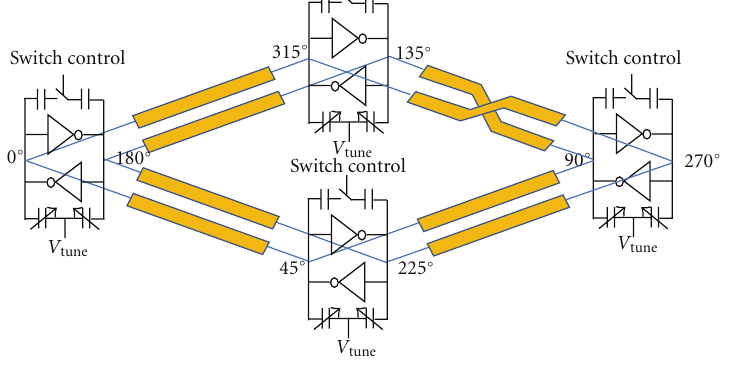
Figure 5: RTW VCO topology.